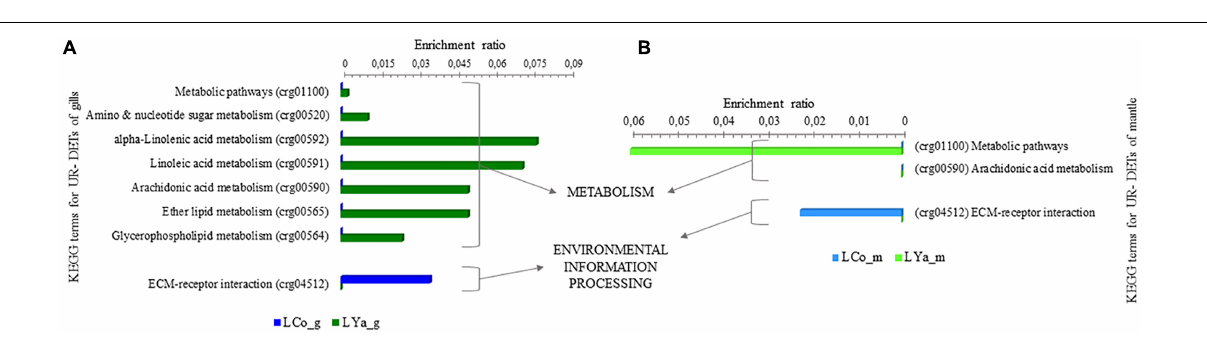
FIGURE 7 | KEGG categorization of differentially expressed transcripts (DETs) for inter-location by tissue comparison. The KEGG terms represented by samples from gills tissue are in (A) and those represented by samples from mantle are in (B) . LCo, local individuals from Cochamó and LYa, locals from Yaldad. _m, mantle samples and _g, gill